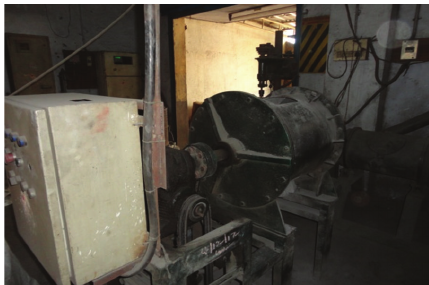
Figure 3: Mixing machine.